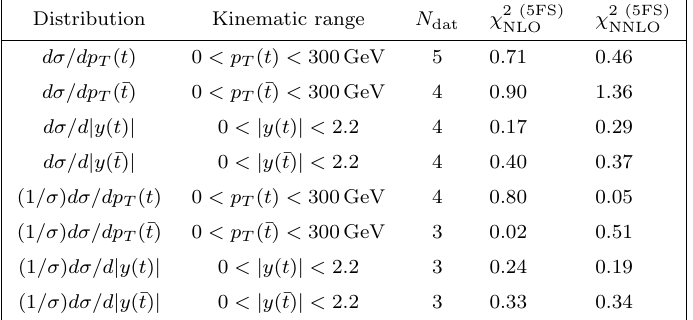
Table 7 . The values of the (cid:31) 2 , eq. (3.2), computed for all of the datasets presented in ref. [13]. We indicate the distribution, its kinematic range, and the corresponding number of data points, N dat . The bin edges for the transverse momentum distributions are 0, 50, 100, 150, 200 and 300 GeV, while for the rapidity distributions they are 0, 0.3, 0.7, 1.3 and 2.2. Theoretical predictions are computed at either NLO or NNLO accuracy in the 5FS in pure QCD; the input PDFs are taken from the NNPDF31 nlo as 0118 and NNPDF31 nnlo as 0118 sets, respectively. Experimental correlations are not provided, therefore they are not included in the (cid:31) 2